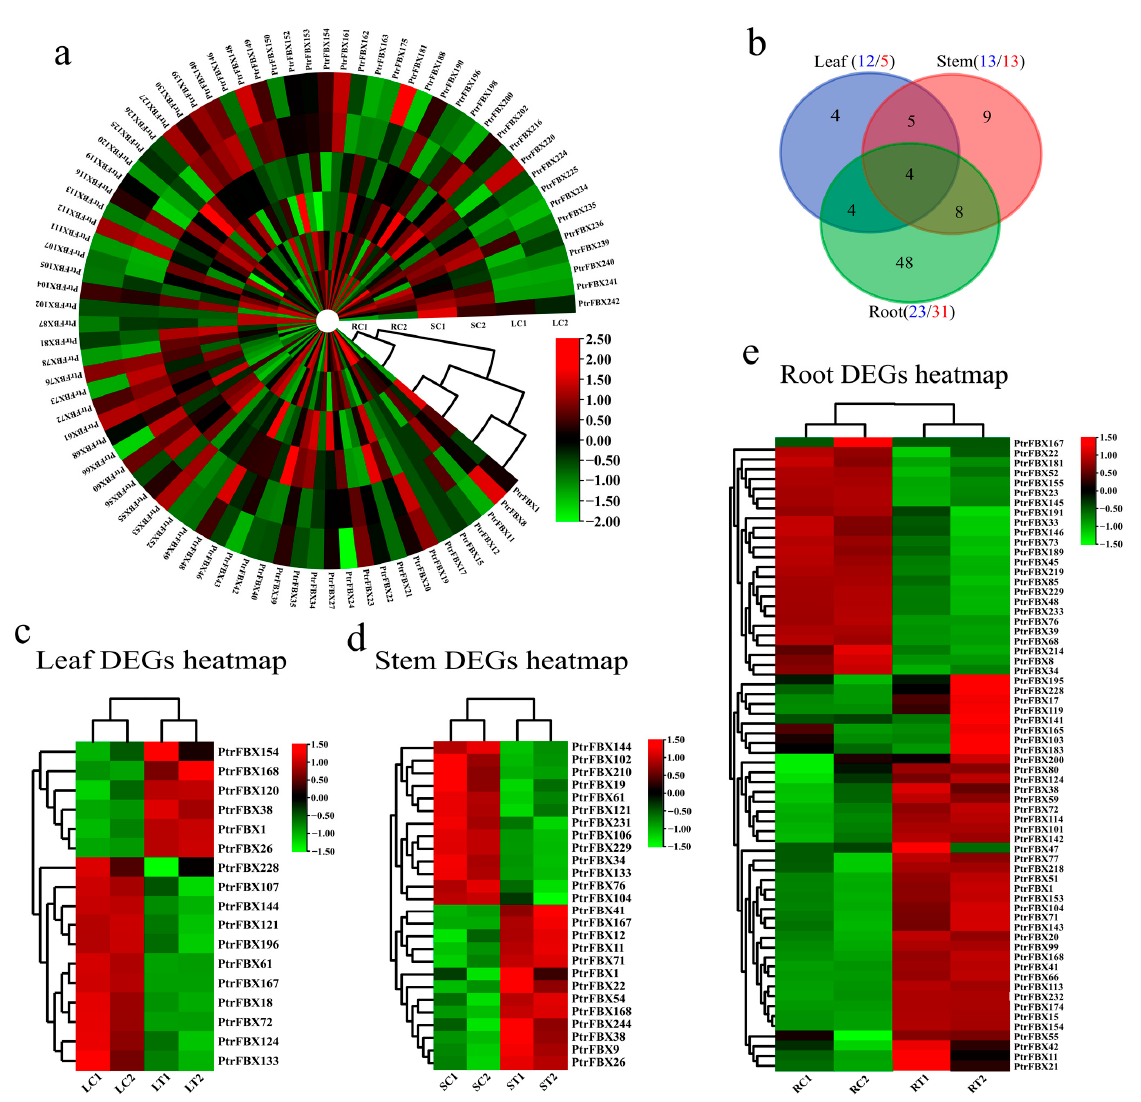
Figure 6. Expression patterns of PtrFBX genes. All heatmap values are scaled by log2 FPKM . ( a ) Heatmap of the roots, leaves and stems of Populus simonii × Populus nigra without salt treatment. ( b ) Venn diagram of DEGs across the three tissues. Blue, pink and green circles denote DEGs of the leaves, stems and roots, respectively. ( c – e ) Heatmap of DEGs in the leaves, stems and roots before and after salt stress. S, L and R denote the stems, leaves and roots, respectively. T and C represent with and without salt treatment, respectively. Red and green boxes denote relative upregulation and downregulation of expression, respectively.